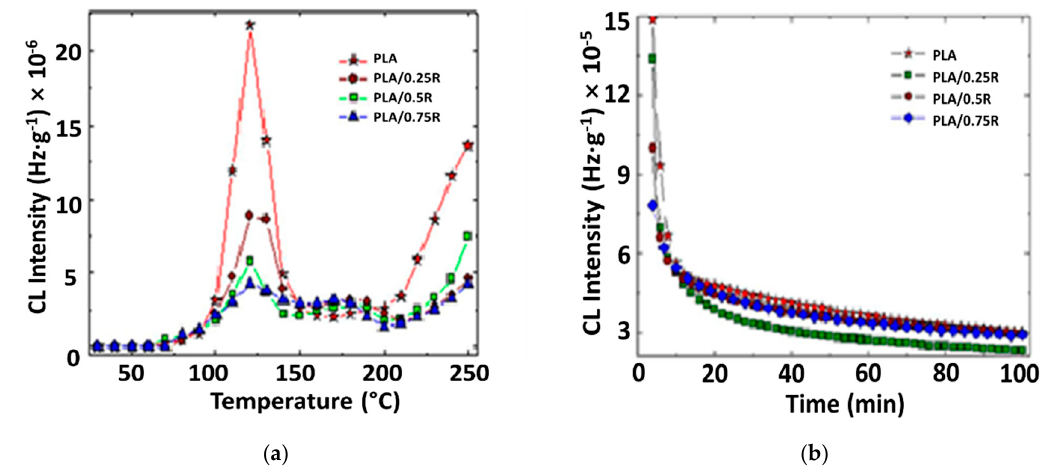
Figure 13. Chemiluminescence (CL) spectra recorded on PLA-based samples irradiated at 20 kGy: ( a ) nonisothermal measurements, heating rate: 3.7 ◦ C min − 1 ; ( b ) isothermal measurements: testing temperature 180 ◦ C